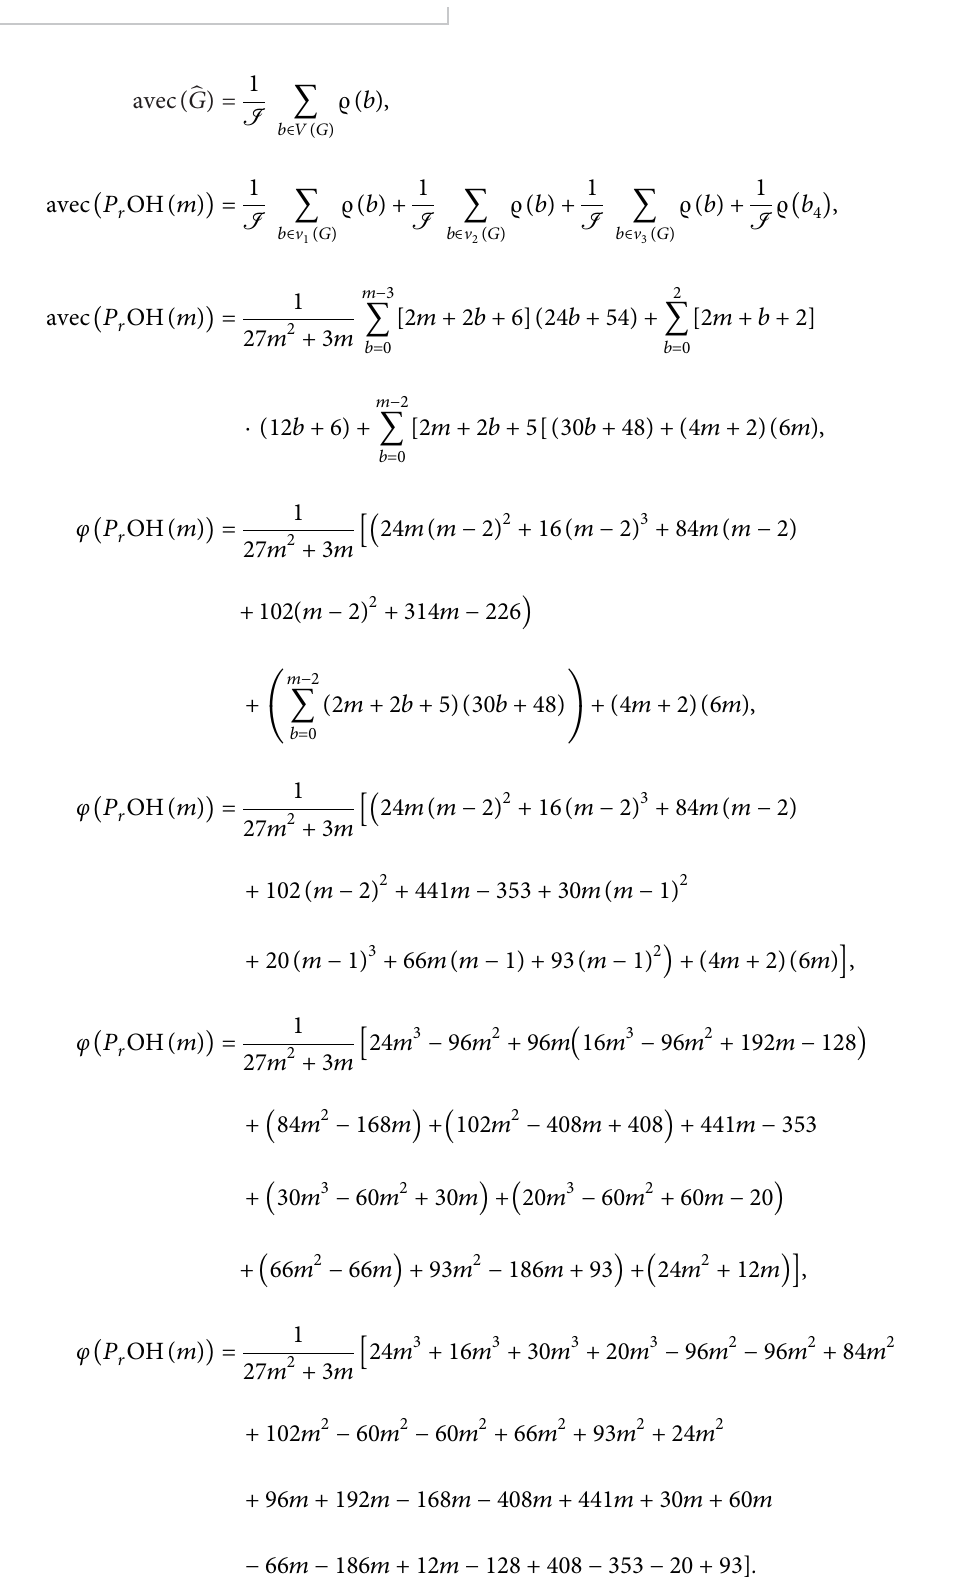
Table 1, we obtained the average eccentricity index